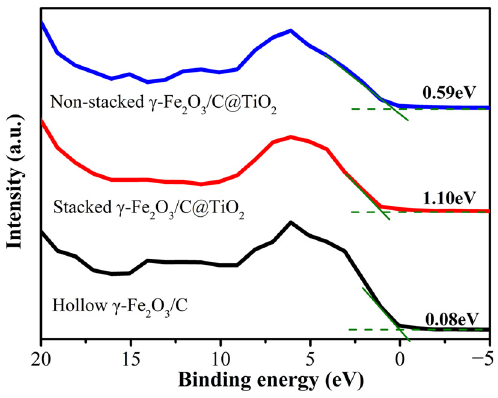
Figure 7. Valance band XPS spectra of non-stacked γ -Fe 2 O 3 /C@TiO 2 , stacked γ -Fe 2 O 3 /C@TiO 2 , and hollow γ -Fe 2 O 3 /C.